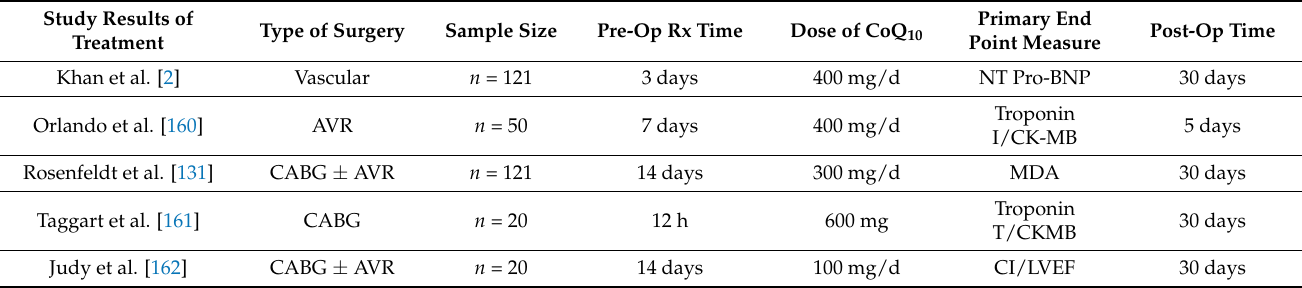
Table 2. Randomized, controlled, double-blind studies testing the effects of preoperative treatment with CoQ 10 vs. placebo on postoperative outcome